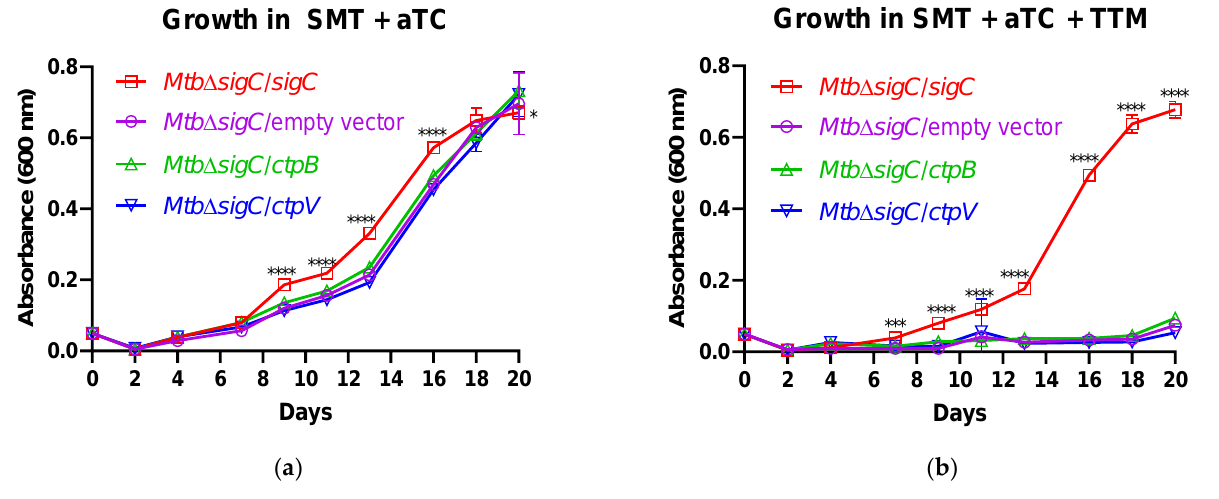
Figure 2. The growth defect of a M. tuberculosis sigC mutant in copper-chelated medium is not reversed by ctpB . Growth of derivatives of M. tuberculosis ∆ sigC that were transformed with an empty vector plasmid or with one encoding the indicated M. tuberculosis gene encoding SigC, CtpB, or CtpV with an N-terminal myc tag was examined after passaging three times in SMT prior to inoculation into fresh medium containing 50 ng/mL aTC (inducer) alone ( a ) or with 50 ng/mL aTC and 0.01 mM TTM (copper chelator) ( b ). Shown are the averages with standard error of three experiments performed in triplicate. Significant differences between the indicated strain relative to all others are indicated (* p < 0.5, *** p < 0.001, **** p < 0.0001).